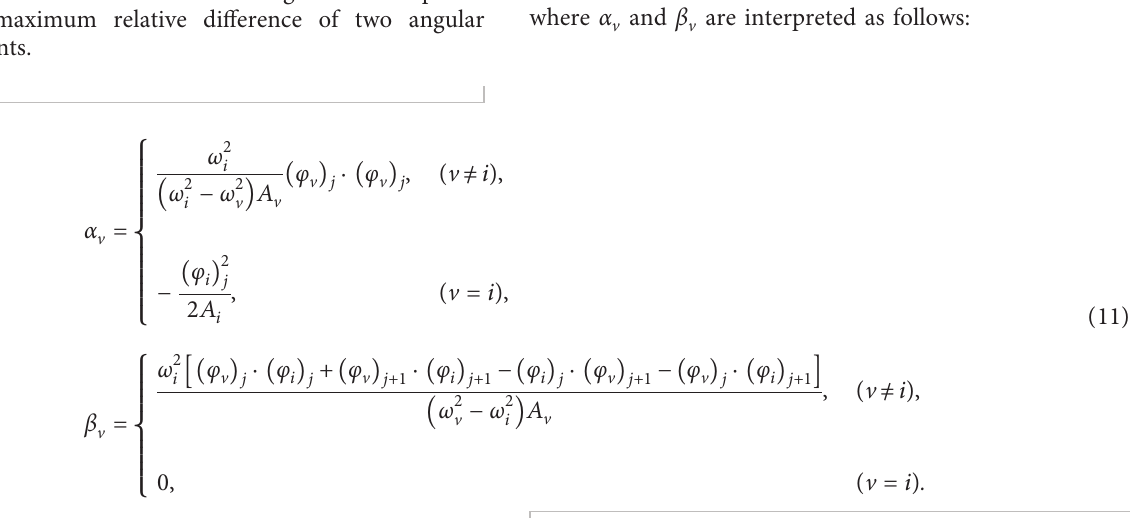
Figure 11: The additional torsional angle.